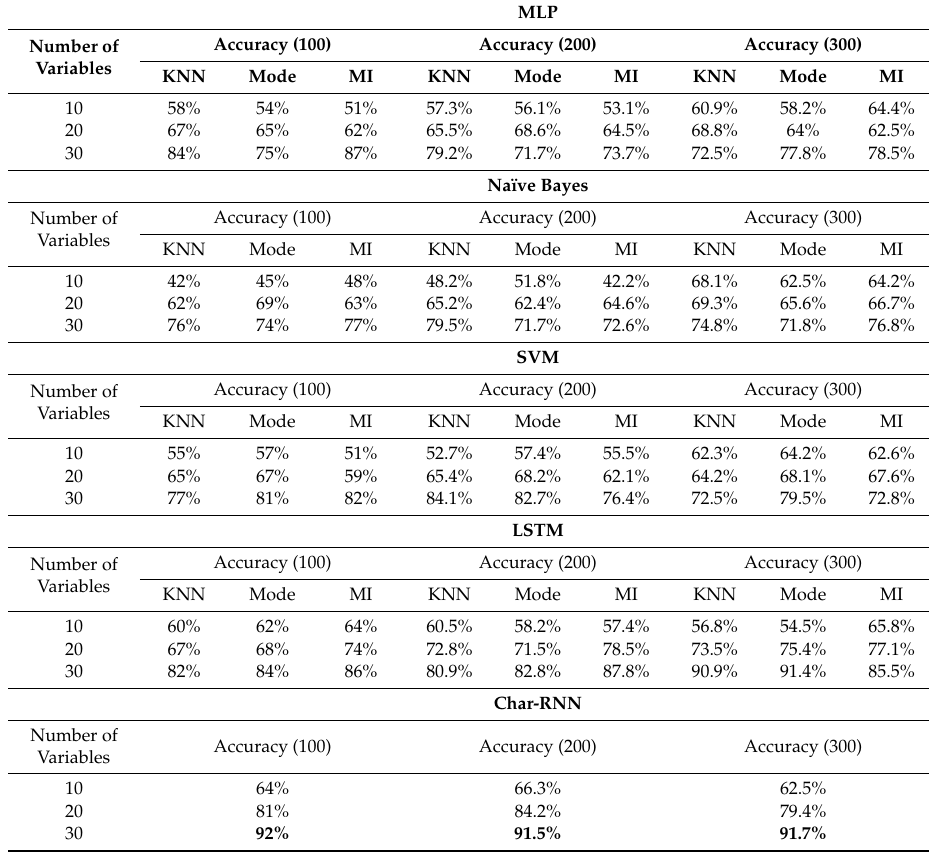
Table 3. Accuracies with varying numbers of selected variables. MLP, multilayer perceptron;